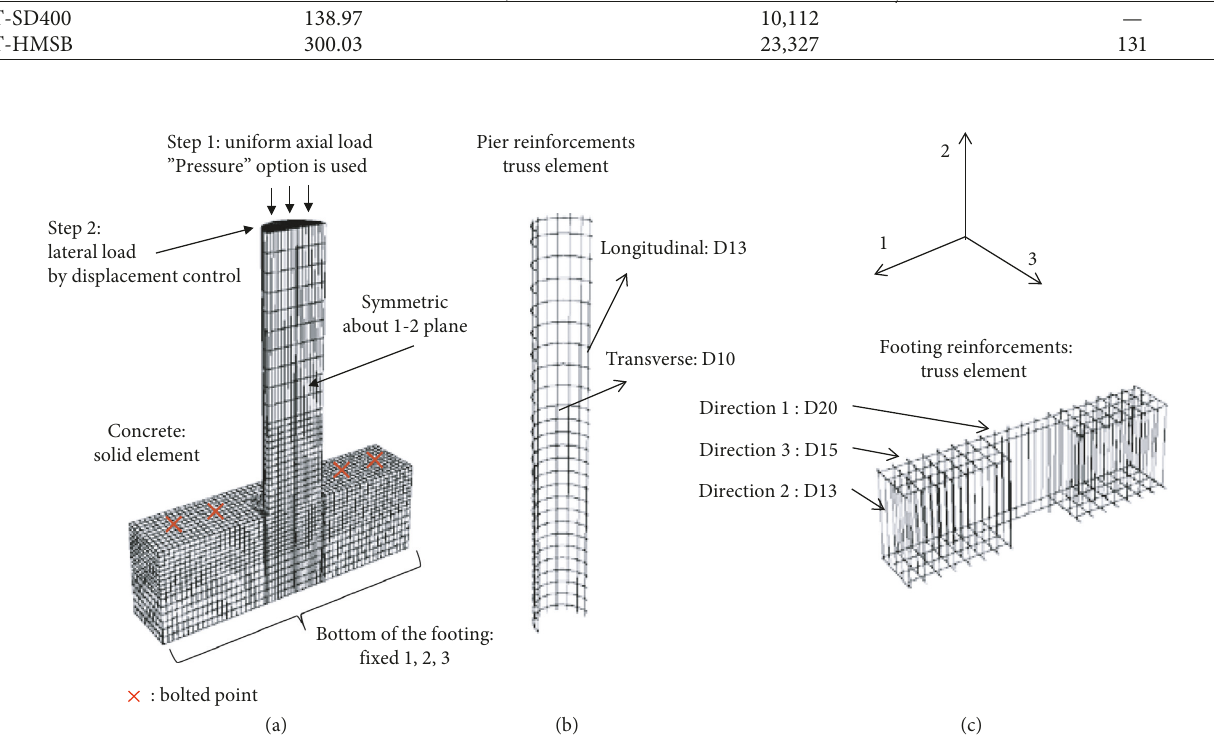
Figure 15: Typical finite-element model: (a) concrete elements, boundary condition, and loading; (b) reinforcing bars in the pier; and (c) reinforcing bars in the